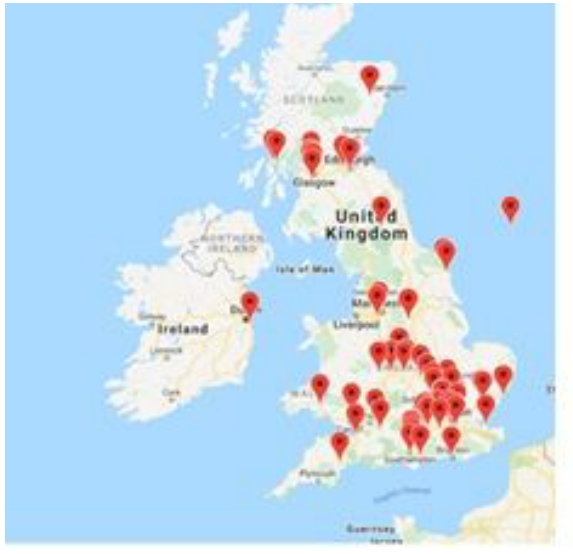
Figure 2: Location of Quiet Project Monitoring stations, as of 15 th